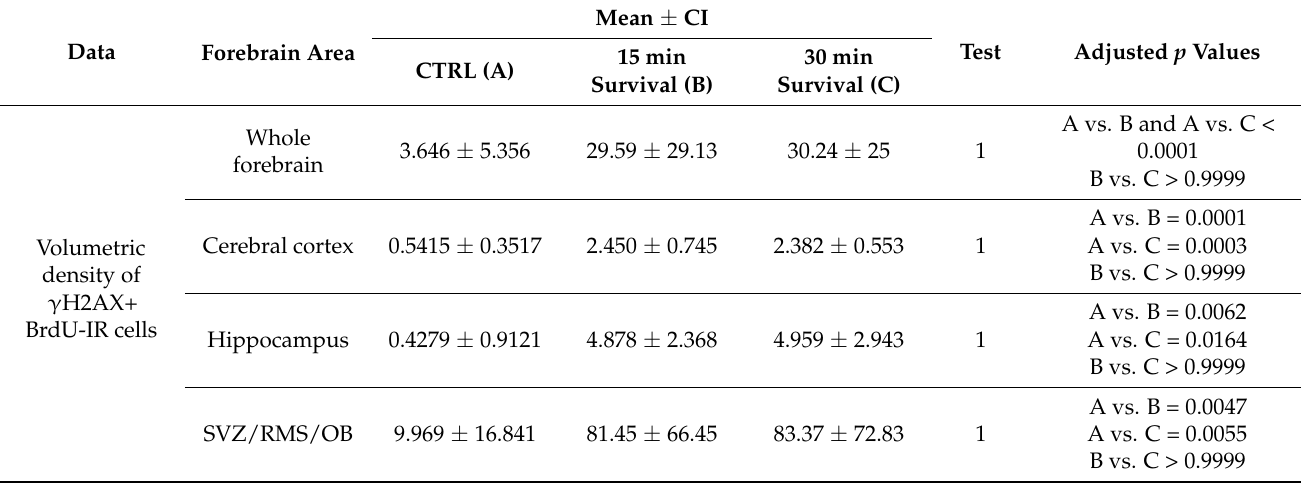
Table A6. Statistical analysis of volumetric densities and percentages of γ H2AX + BrdU immunoreactive cells. Legend : 1 = Kruskal-Wallis and Dunn’s multiple comparisons test. See Figure 13 for